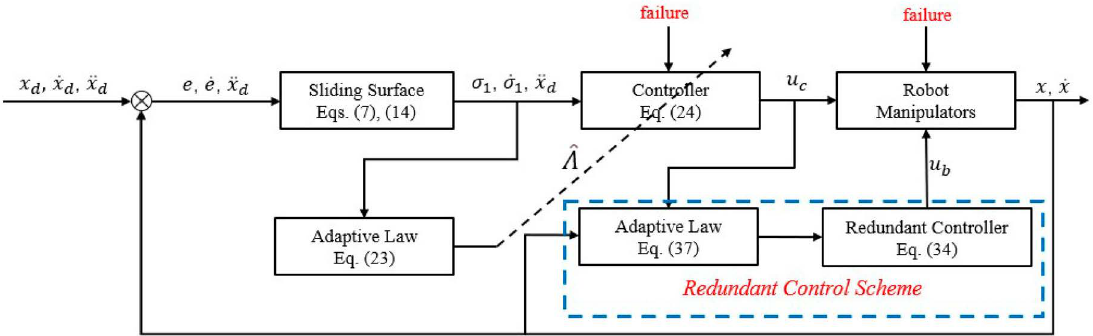
Figure 2. Illustration of the design procedure of redundant